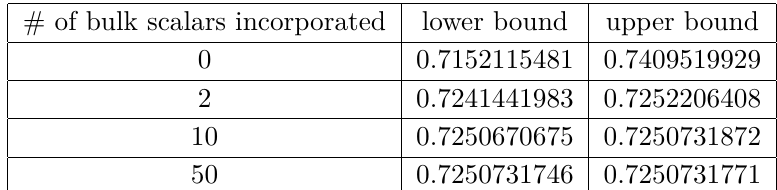
√ (cid:16) (cid:17) 1 4 = 0 . 72507317708 . . 1 5 − 2 10